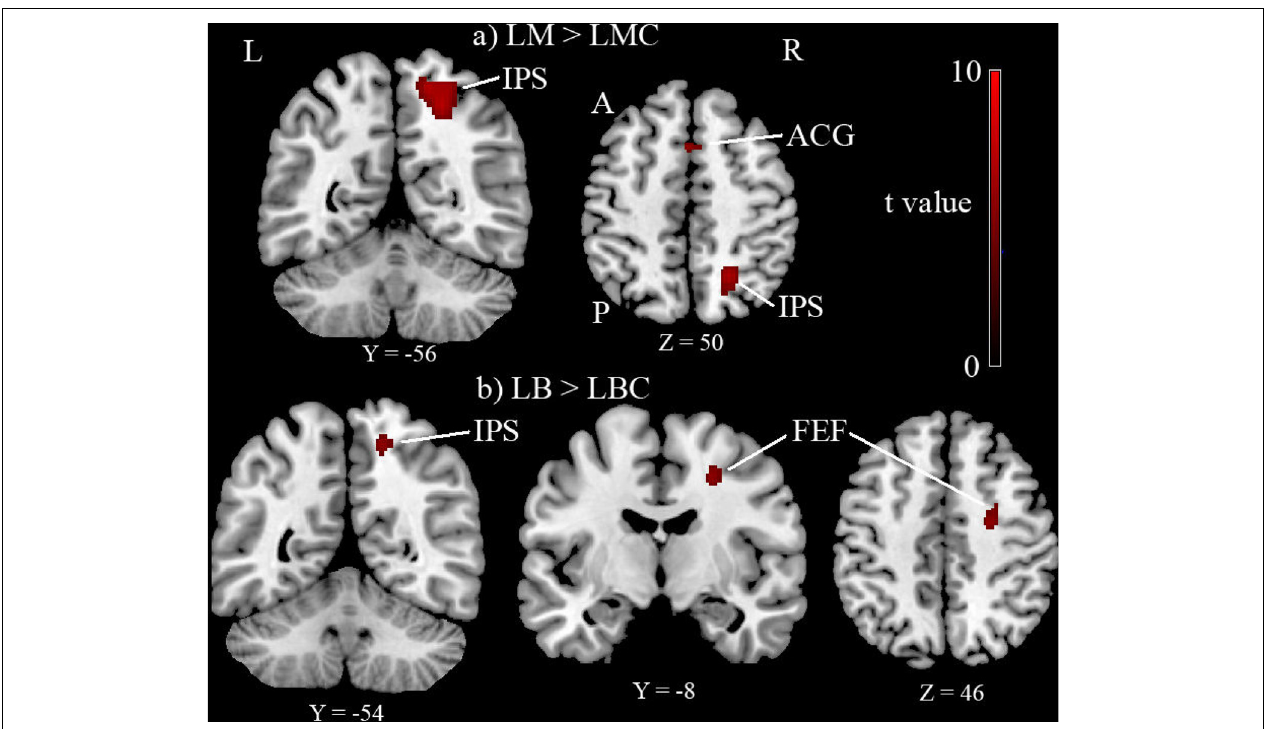
FIGURE 2 | Group results ( n = 11) thresholded at p < 0.05 corrected for multiple comparisons. (A) Landmark task (LM) versus Landmark control (LMC) activated intra-parietal sulcus (IPS), anterior cingulate girus (ACG) and lateral